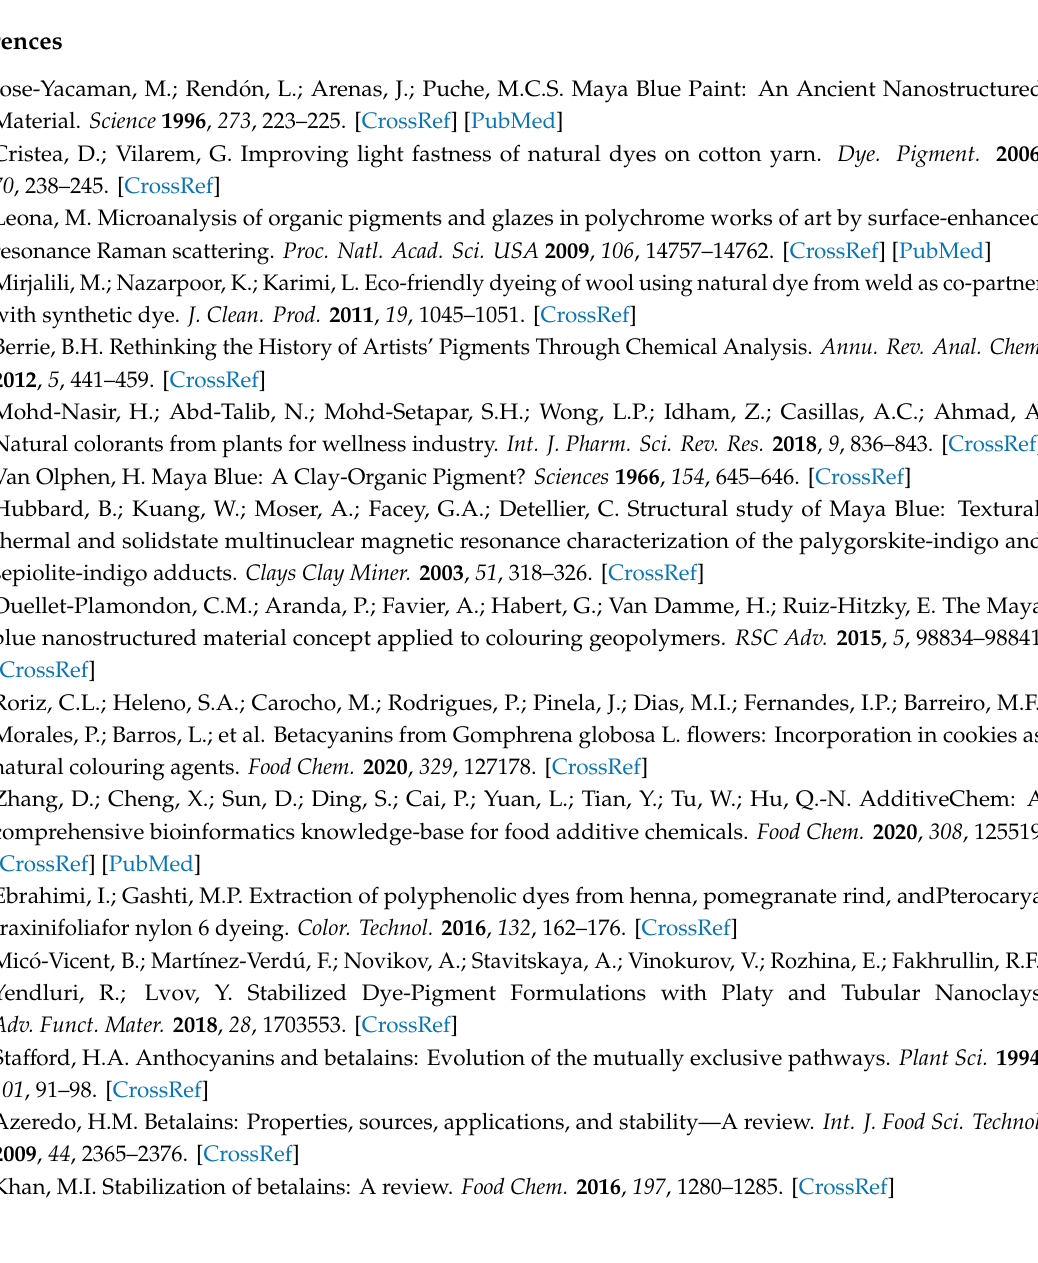
Table S1: Color parameters of pure betanin, Pal and Hal; Table S2: Chemical compositions and their atomic percents of Pal, betanin / Pal, Hal, and betanin / Hal; Figure S1: The element mapping images of (A) betanin / Pal and (B) betanin / Hal: (a) C, (b) N, (c) O, (d) Si, (e) Mg, (f), Al (g) Fe, (h) Ca; Figure S2: Digital images of the pure betanin, betanin / Pal and betanin / Hal at di ff erent heating temperatures; Figure S3: Digital images of the pure betanin and betanin desorbed from the betanin / Pal and betanin / Hal hybrid materials after being immersed for 24 h in (a) distilled water, (b) 0.1 M HCl and (c) 0.1 M NaOH,